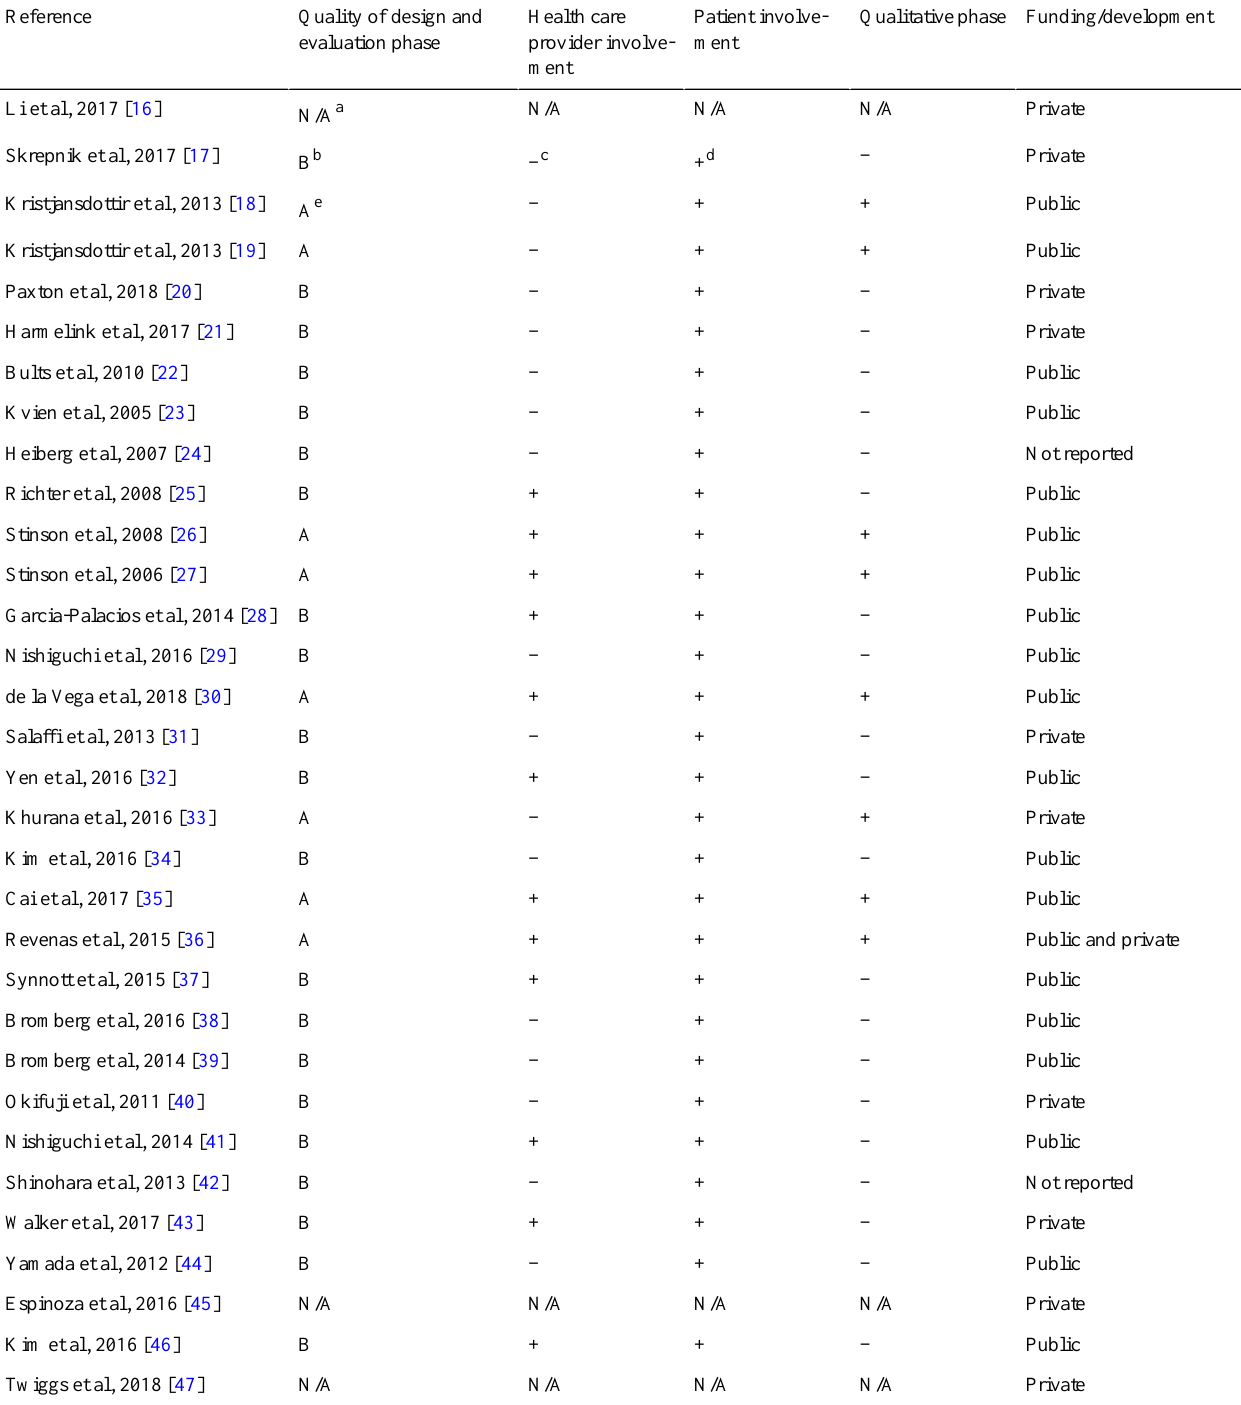
Funding/developmentQualitative phasePatient involve- mentHealth care